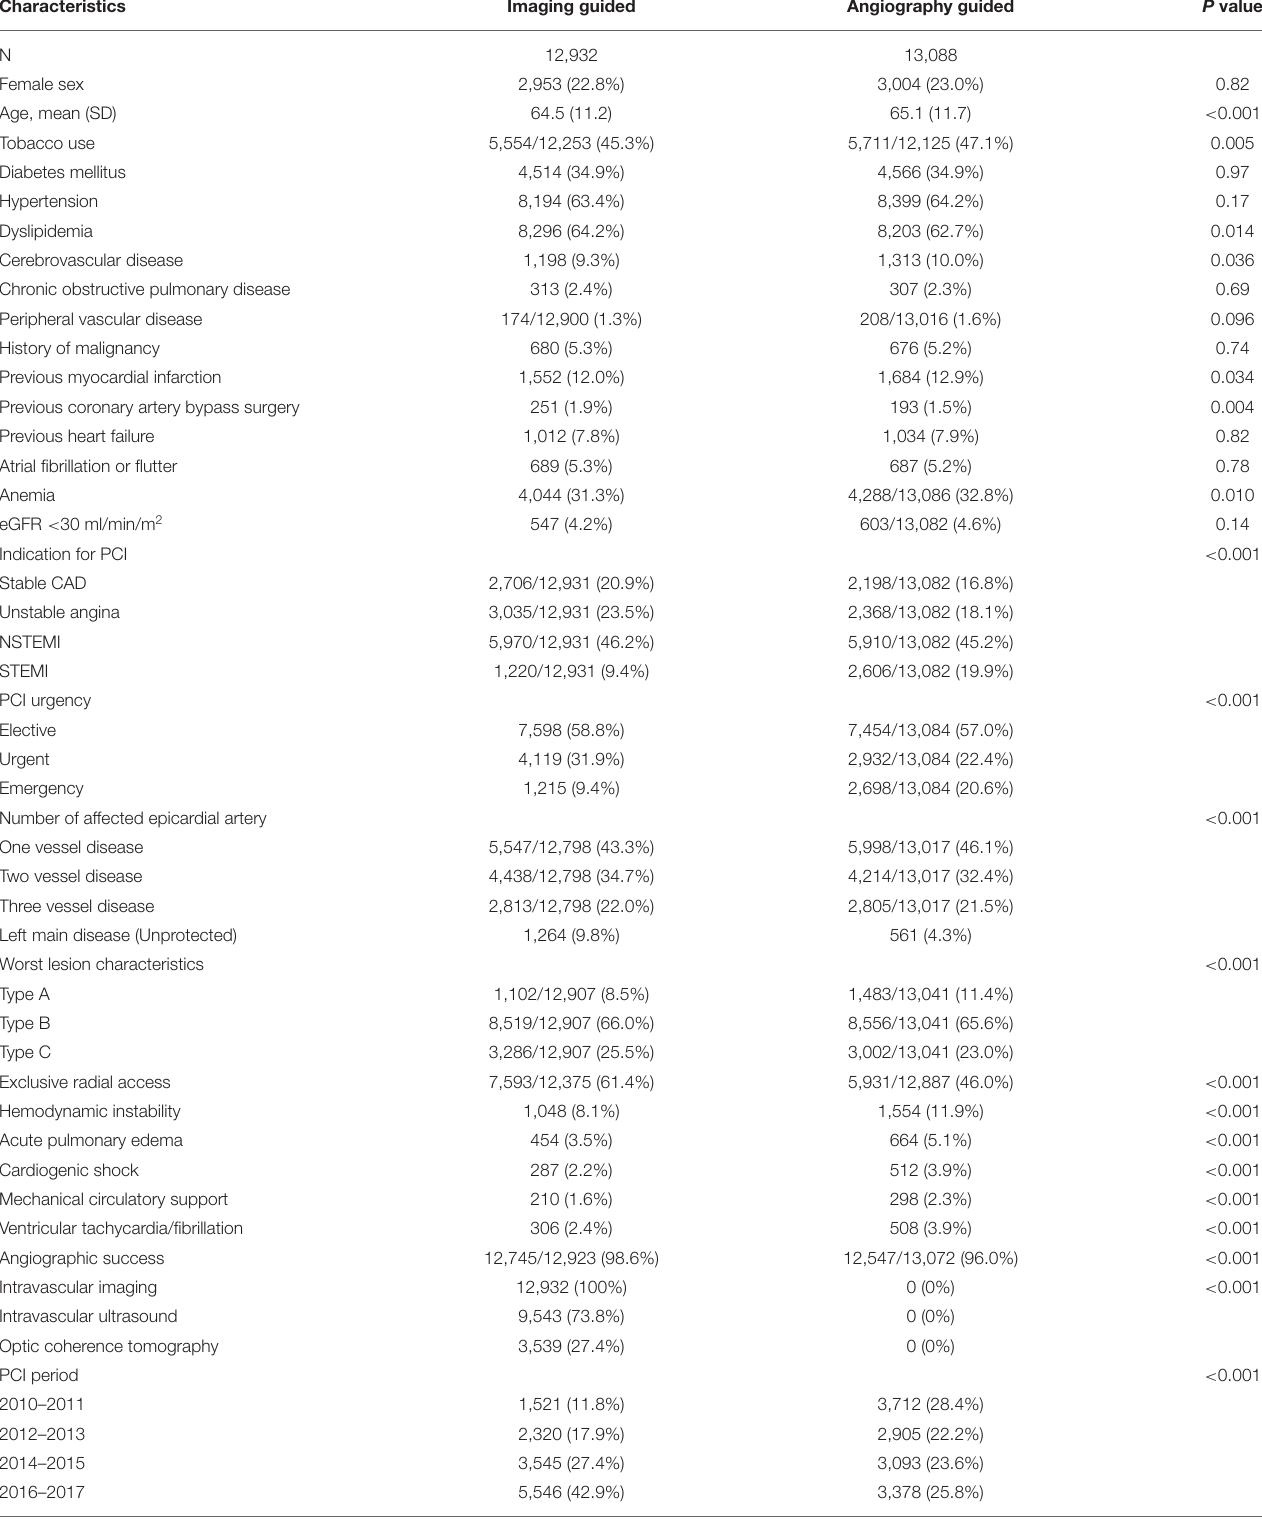
TABLE 1 | Baseline characteristics of the study population were stratified by imaging guidance at an individual level. Characteristics Imaging